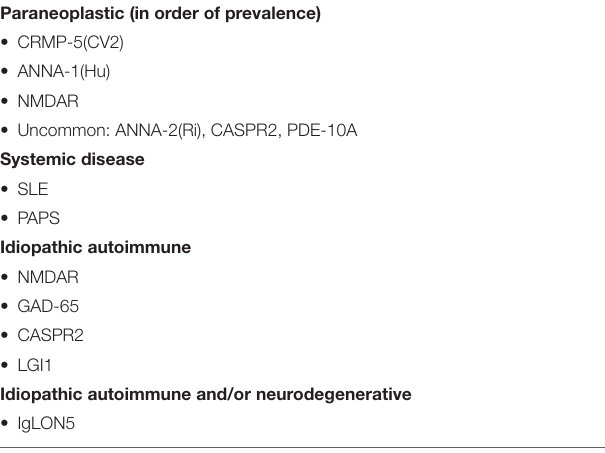
TABLE 2 | Autoimmune causes of chorea. Paraneoplastic (in order of prevalence)